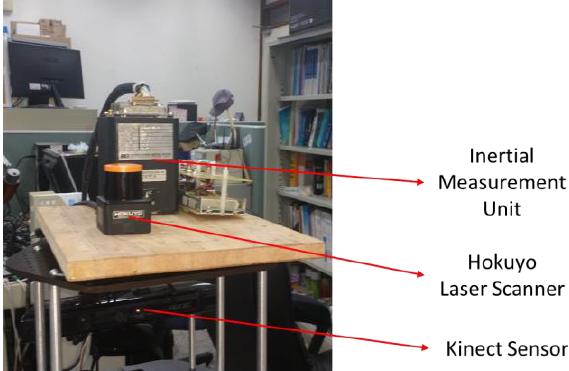
Figure 2. The payload design of indoor MMS prototype